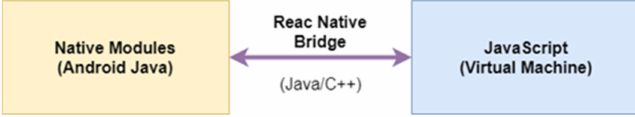
Figure 10. React Native basic operation.